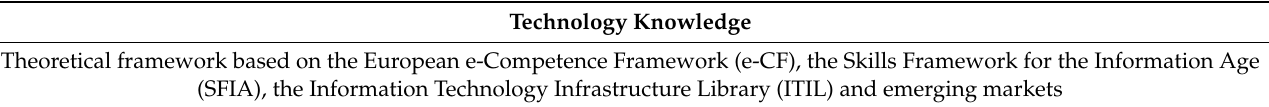
Table 1. Technological Competencies Profile